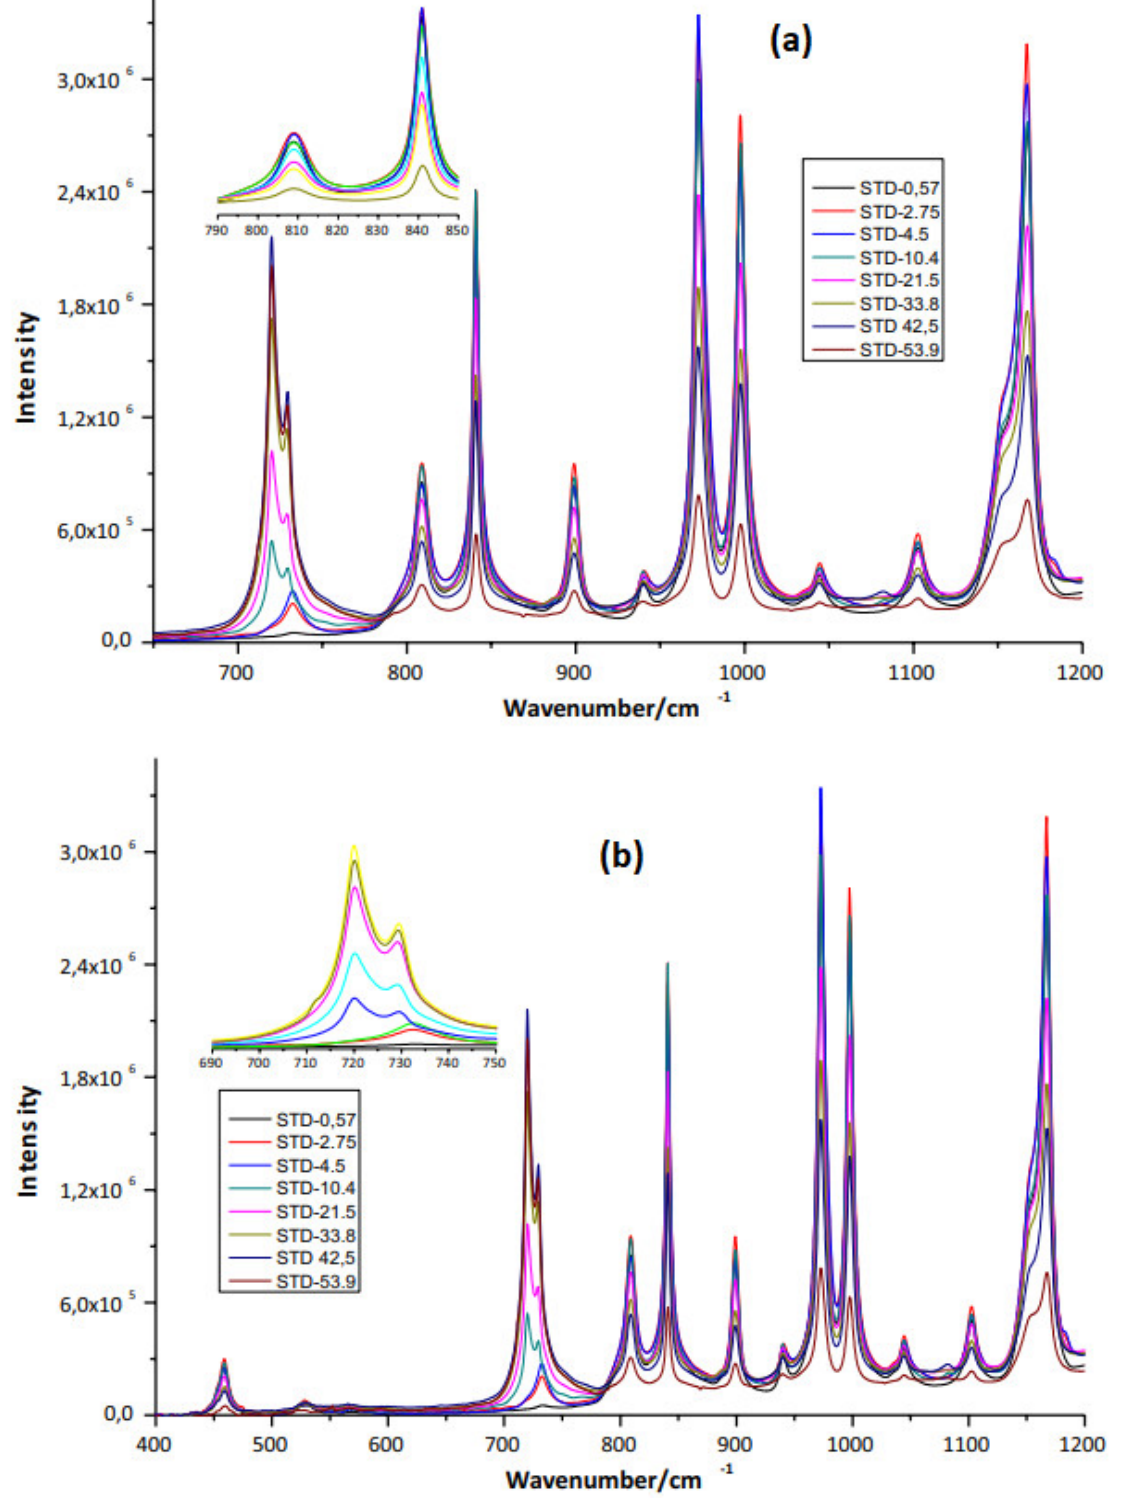
Figure 1. Infrared spectra of ethylene standards in ethylene-propylene impact copolymers. ( a ) Between 600–1200. ( b ) 400–1200.